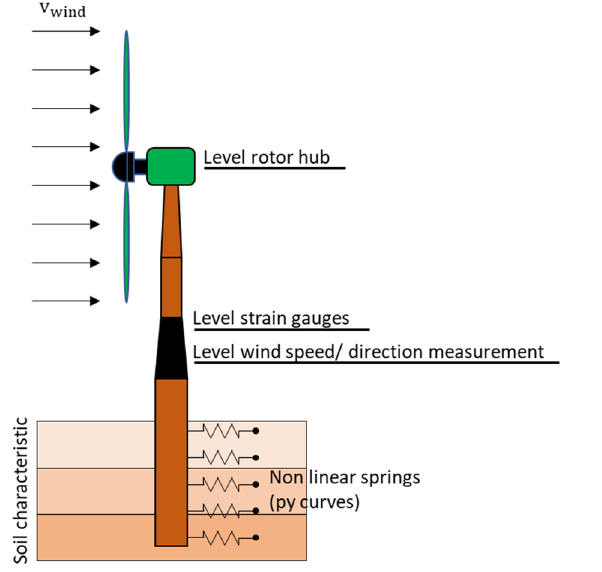
Table 2. Characteristic values (shape and scale parameter) of shear force, 𝑉 (cid:3050)(cid:3036)(cid:3041)(cid:3031) , and the moment, 𝑀 (cid:3050)(cid:3036)(cid:3041)(cid:3031) , using an FE model and considering the soil–pile interaction.